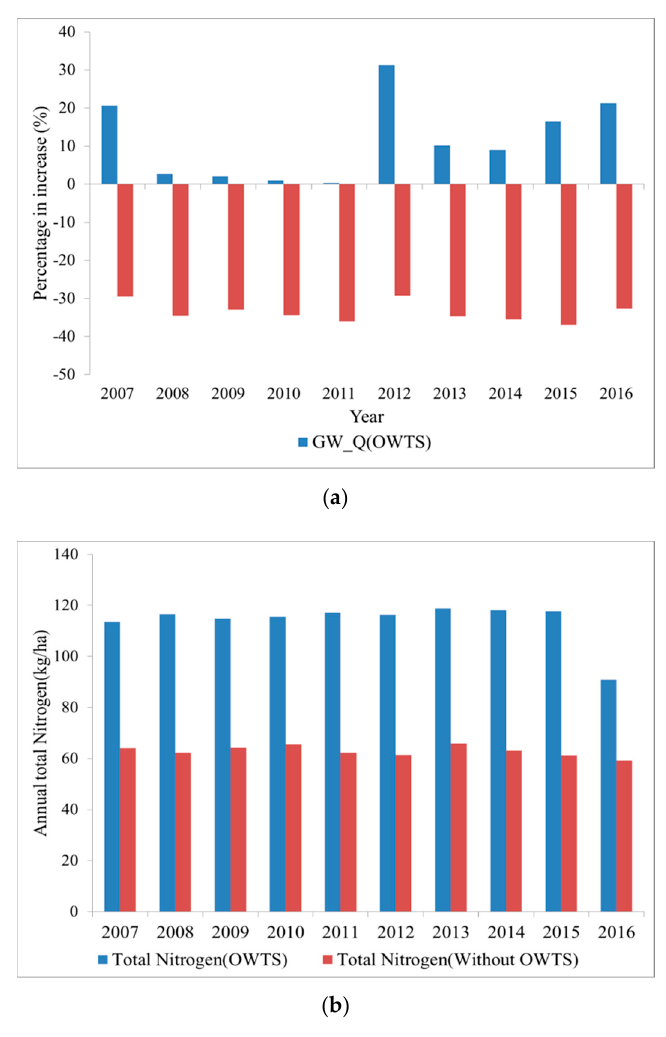
Figure 5. Plots of groundwater flow and total nitrogen inputs. Both charts are from 1 January 2007 to 31 August 2016. ( a ) Plot of annual percent increase in the groundwater contribution to streamflow between model simulation with and without OWTS at the subbasin scale; ( b ) Plot of annual total nitrogen with and without OWTS.